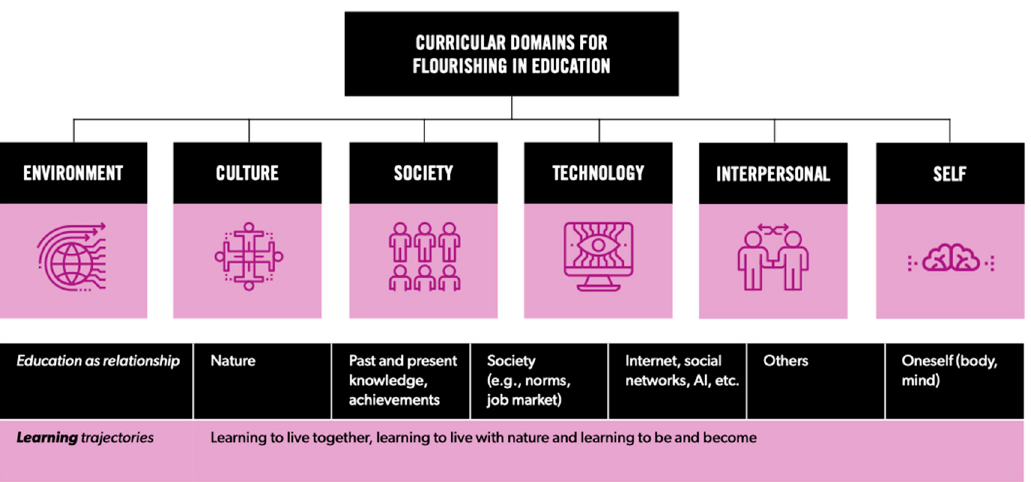
Figure 1. ISEEA Curricular Domains for Flourishing in